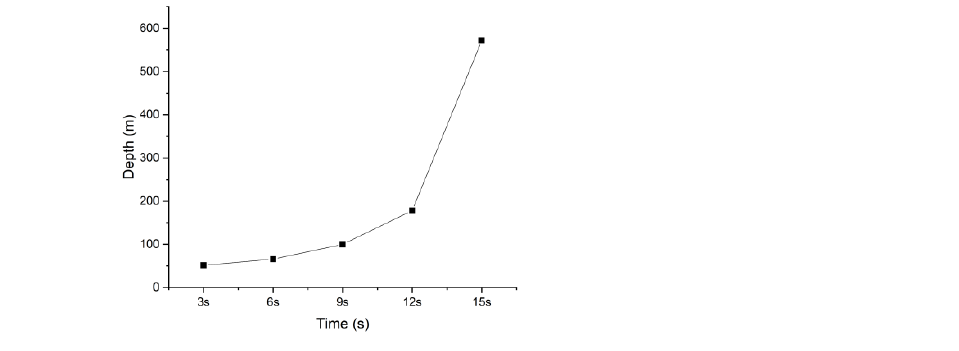
Figure 11. Dangerous resonance position of tubing under different pump shutdown times.